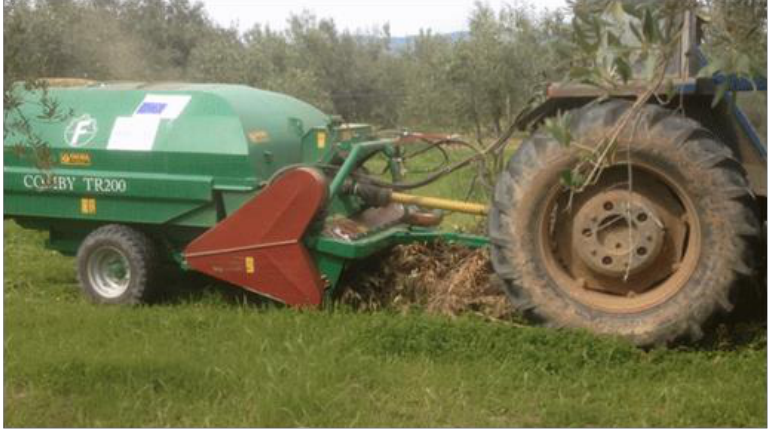
Figure 3. The Facma Comby TR200.